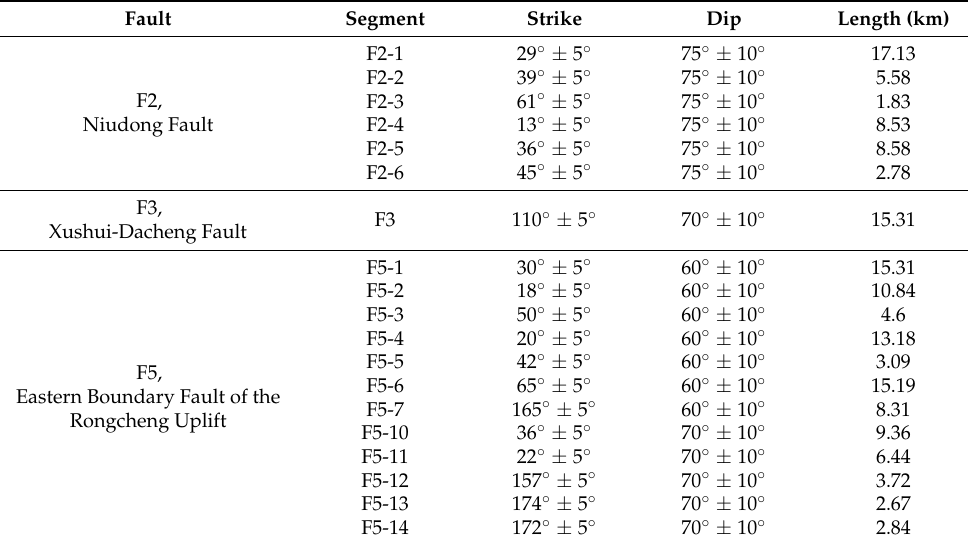
Table 1. The attribute parameters of the main active faults in the Rongcheng deep geothermal reservoir.